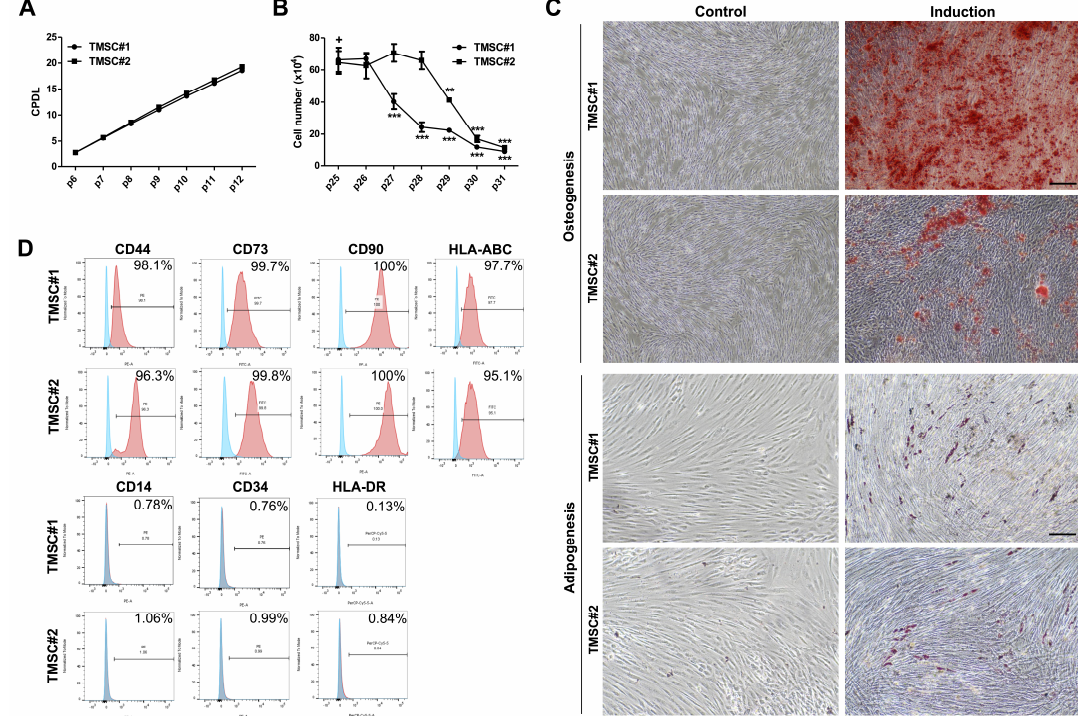
Figure 1. Characteristics of TMSCs as a source for MSCs therapy. ( A ) TMSCs were obtained from palatine tonsils of two di ff erent donors and the cumulative population doubling level (CPDL) was calculated through continuous passaging from p6 to p12; ( B ) To verify the onset time of cellular senescence, the absolute number of TMSCs was counted from passage 25 to 31. All data are represented asmean ± S.D. p -value = ** < 0.01, *** < 0.001, comparedtothepassage25markedas‘ + ’; ( C )After2weeks of induction into the osteogenic or adipogenic lineage, the di ff erentiated TMSCs, as well as naïve controls, were stained with Alizarin Red S for detecting osteogenesis ( left ) and Oil Red O stain ( right ) for adipogenesis. Representative microscopic images were shown, scale bar = 250 µ m; ( D ) The expression of typical positive ( top ) and negative ( bottom ) MSCs surface markers was determined by flow cytometric analysis. The peak of TMSCs stained with isotype IgG control was shown in blue and those with a specific antibody in red in the